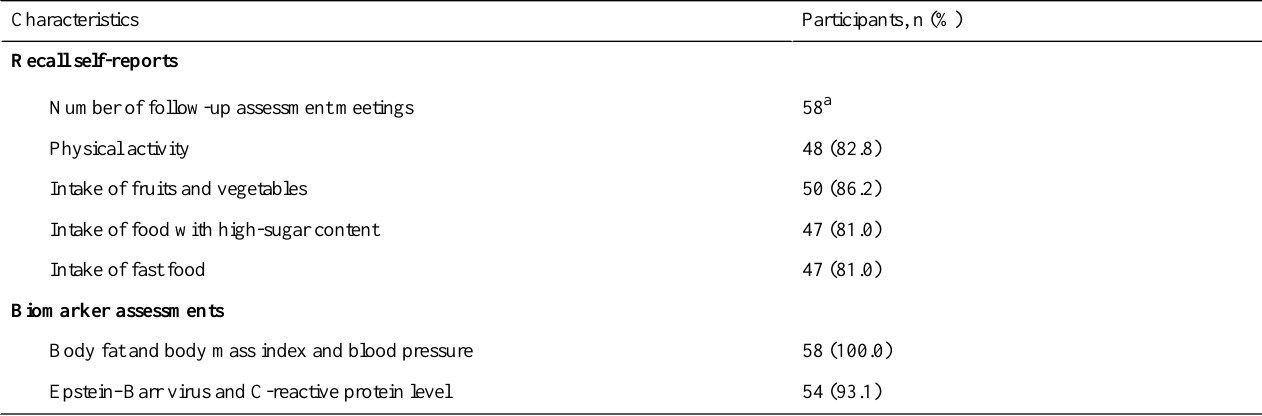
Table 5. Participation rates for ecological momentary assessments and diary surveys, recall self-reports, and biomarker assessments